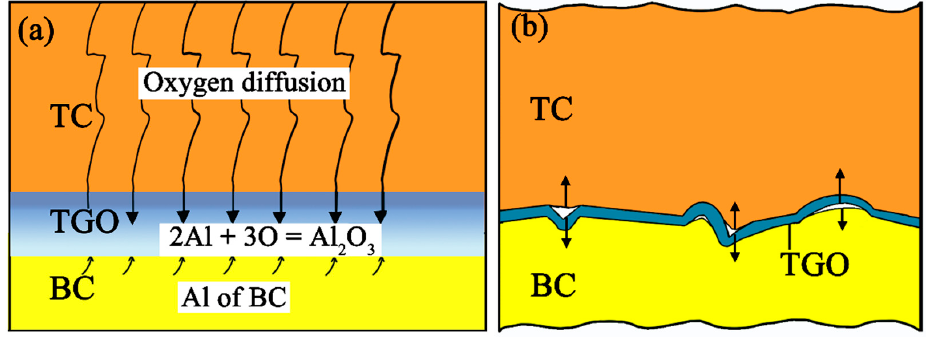
Figure 12. ( a ) Schematic diagram of the oxidation interface and ( b ) failure modes.